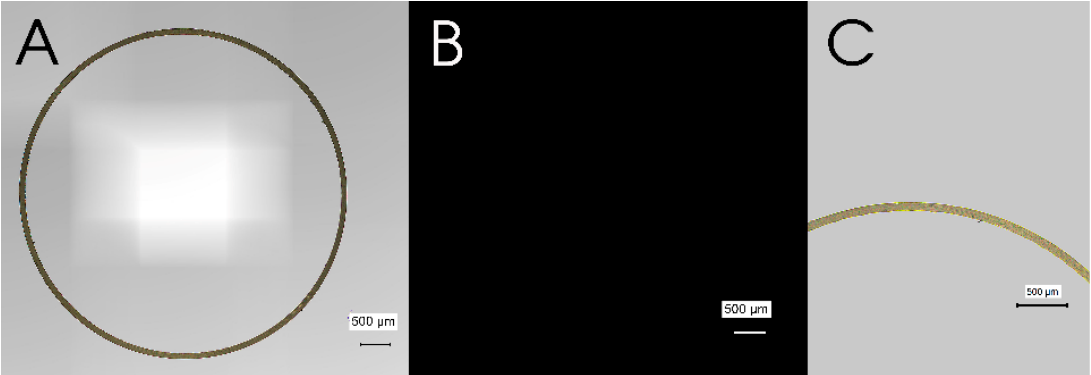
Figure 3. Cross-sectional images of a pristine gelatin capsule. ( A ) a brightfield stitched image, ( B ) a fluorescent stitched image with a red excitation filter, and ( C ) a single brightfield image of the wall of a gelatin capsule. Scale bars indicate 500 µ m.